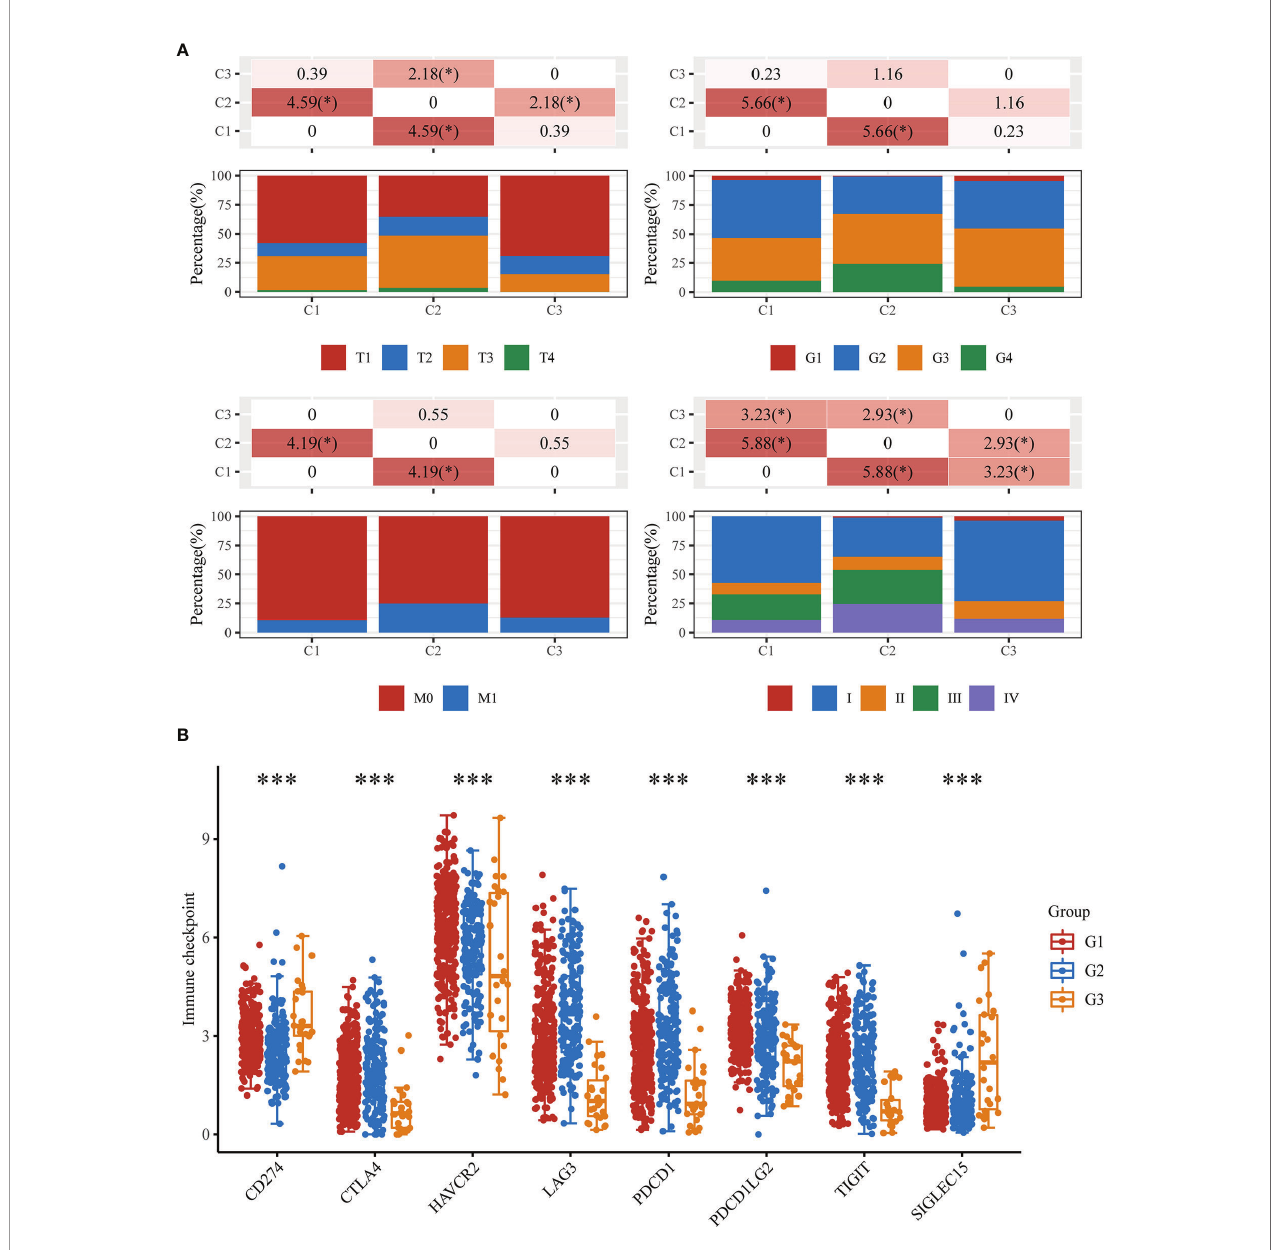
FIGURE 5 | Clinicopathological and immune checkpoint characteristics in the three subtypes of KIRC. (A) Differences in clinicopathologic features among the three subtypes. (B) Expression levels of 8 immune checkpoint genes in the three subtypes. *p < 0.05, ***p <